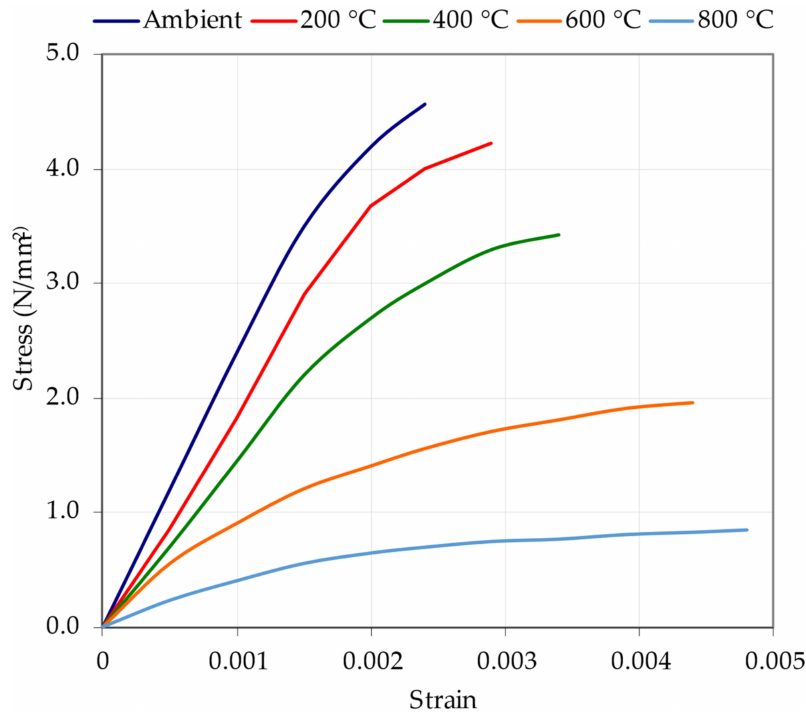
Figure 11. Stress–strain relationship for 1000 kg/m 3 density at varying